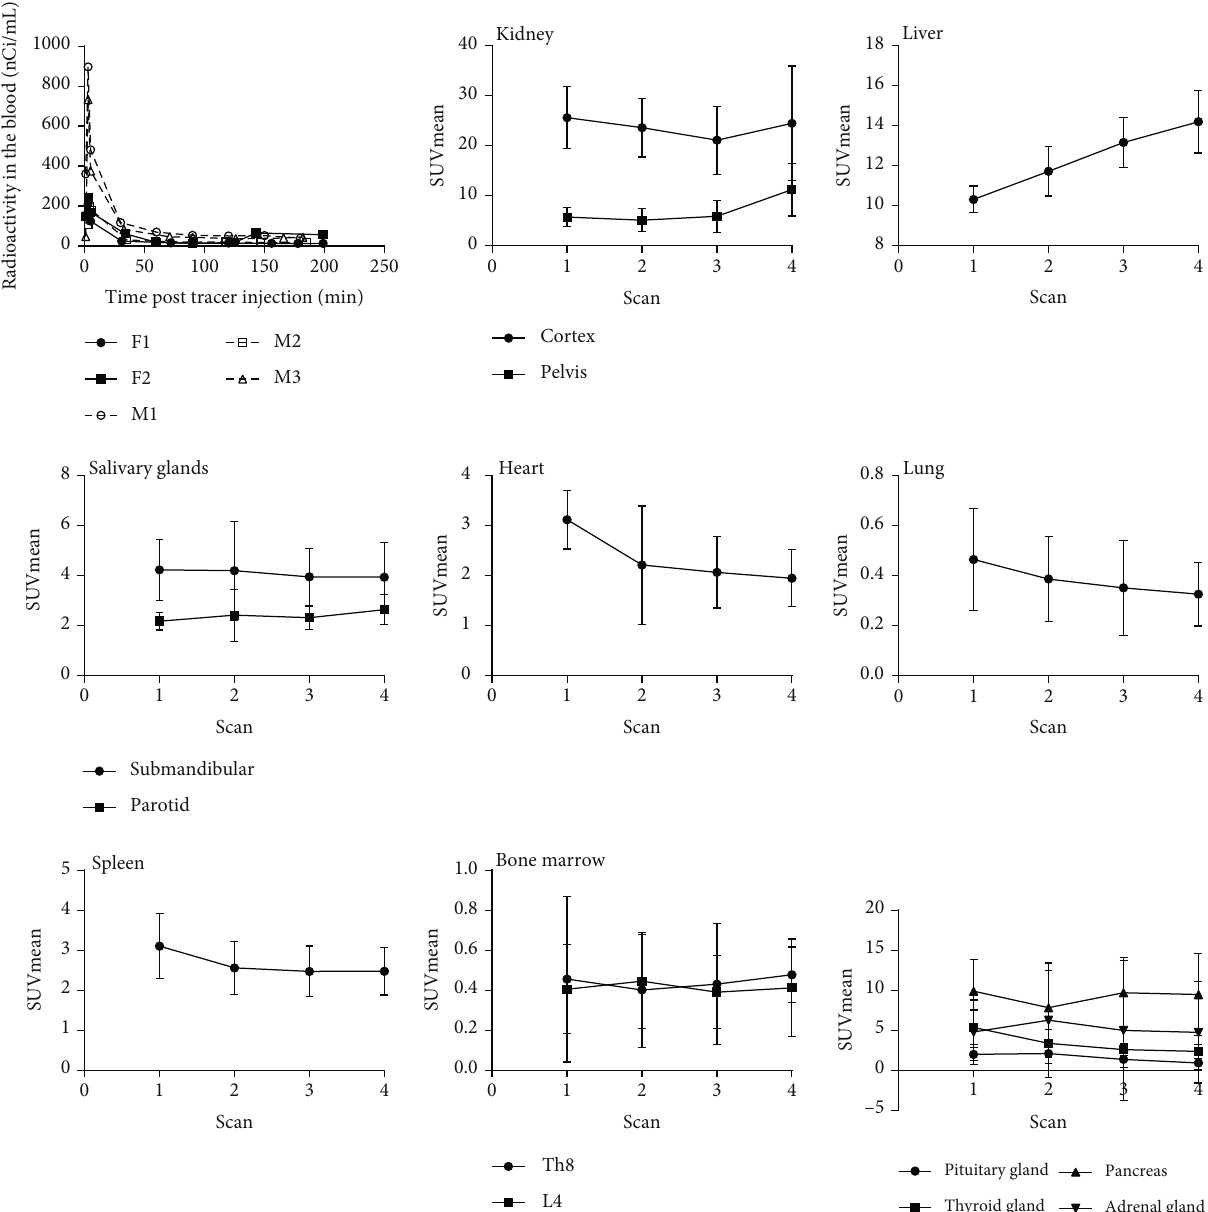
Figure 3: Time-activity curves for the blood and eight source organs in six study